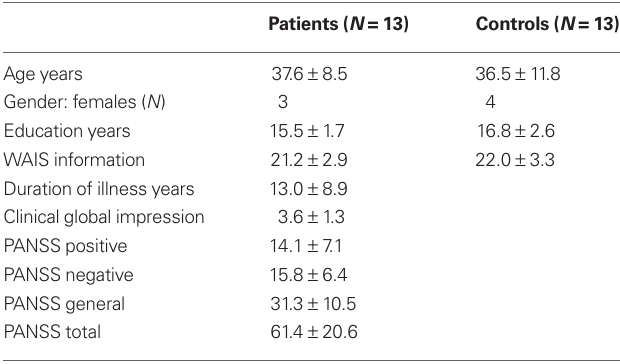
Table 1 | Group description mean ± SD.